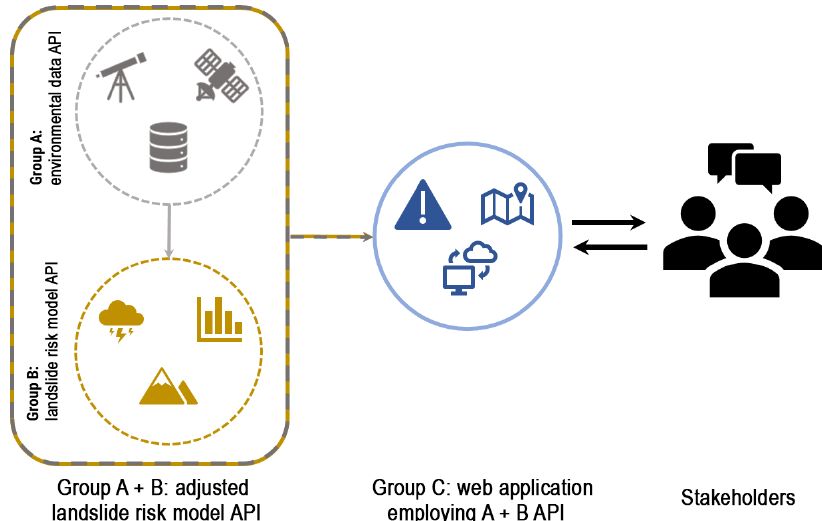
Figure 5. Use-case scenario for implementation of APIs developed within hydrological sciences. Group A collates the most recent earth- and ground-based observations of land cover, topography, and climate data for an in-house project yet allows an API to interact with an analysis-ready, spatially explicit dataset for their region of interest. Group B is interested in geomorphological processes and has developed a model to predict likely occurrence of mass movements, which they also provide access to via an API. During a period of extreme rainfall over a scientifically unrelated region, both groups decide to adjust their methods and API to provide pertinent data (group A), which feed into predictions of landslide risk (group B). Finally, a disaster relief organization (group C) can swiftly act and use the outputs from the adapted API (A + B) to develop a simple web application with maps and warnings for use by the general public in the affected